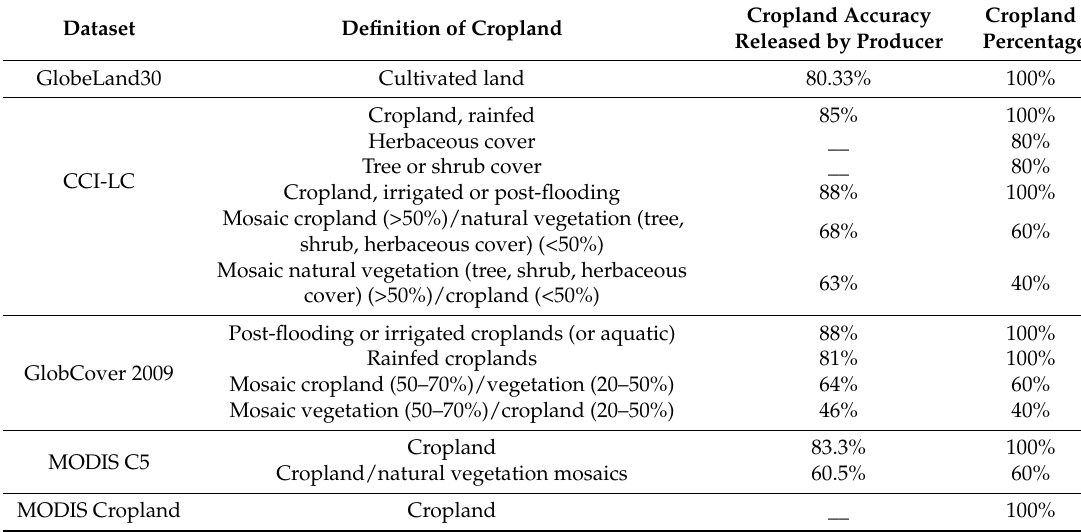
Table 2. Cropland definition and percentage